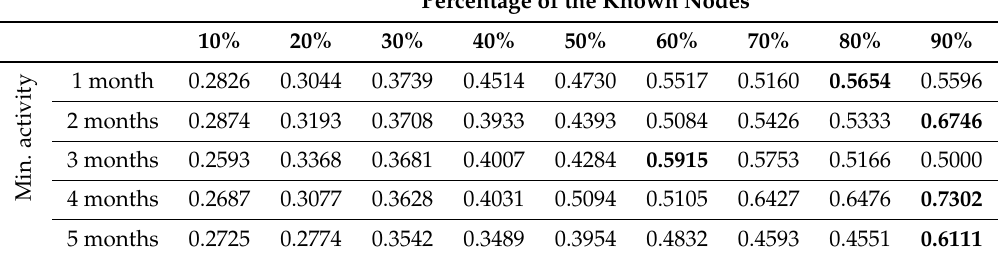
Table A20. F-score macro average for the collective classification of three levels of the hierarchy in the Enron dataset. The values which are bolded are the best results for a given minimum communication activity.